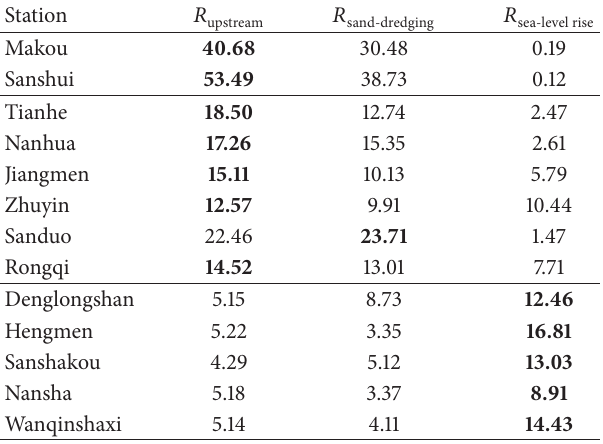
Table 8: Changing ratio 𝑅 caused by three driving factors (unit: %). Station